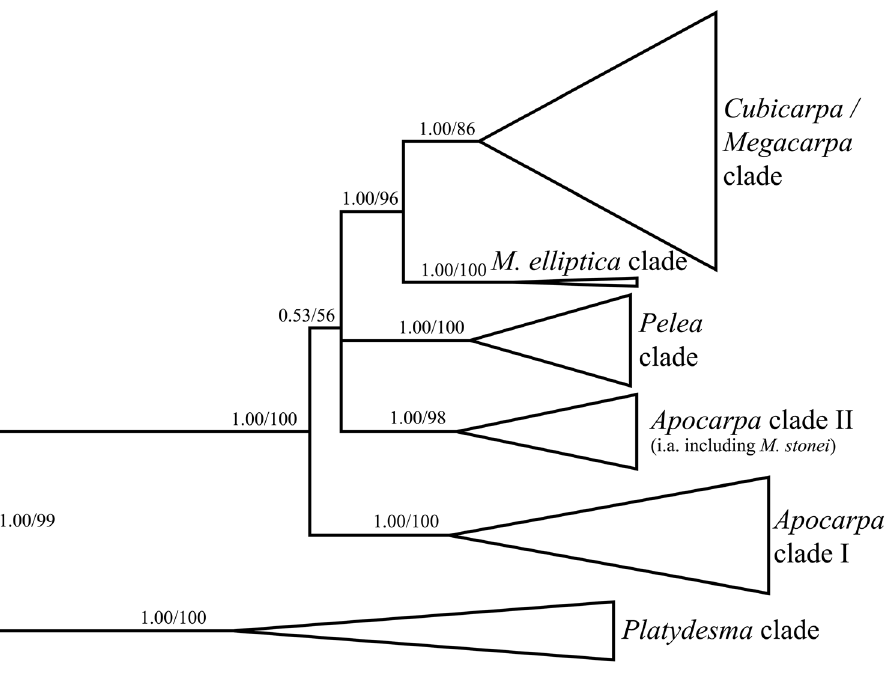
Figure 4. Phylogenetic placement of Melicope stonei K.R. Wood, Appelhans & W.L. Wagner based on four nuclear and two plastid markers (modified from Appelhans et al. 2014c). The phylogenetic tree only shows the Hawaiian radiation of Melicope . The terms Apocarpa , Cubicarpa , Megacarpa and Pelea refer to the former Hawaiian sections of Melicope/Pelea (Hartley & Stone 1989). The support values are displayed above the branches and the first value represents the Bayesian posterior probability values (pp), followed by the bootstrap values (bs) from the Maximum Likelihood